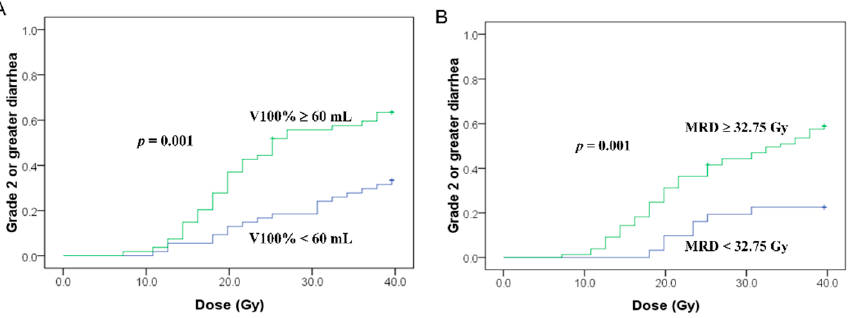
Figure 1. Small bowel volume effect ( A ) and rectal dose effect ( B ) for Grade 2 or greater diarrhea. The horizontal axis is the cumulative prescribed dose to the whole-pelvic target.